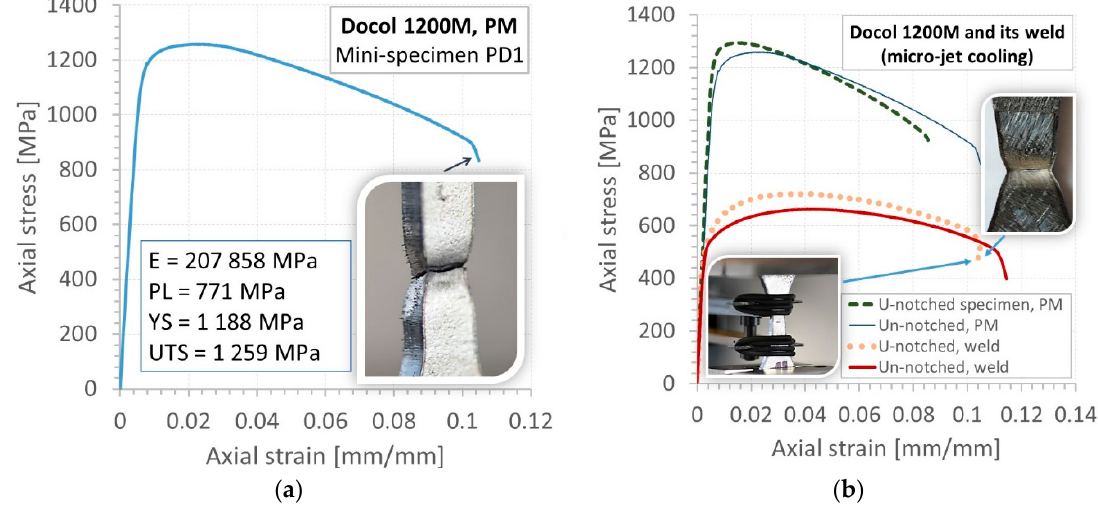
Figure 5. Tensile characteristics of the Docol 1200 M: ( a ) flat (un-notched) mini-specimen ( b ) applying U-notched and un-notched specimens to parent material (PM) and weld (micro-jet), E—Young’s modulus, PL—proportional limit, YS—yield stress, UTS—ultimate tensile strength.